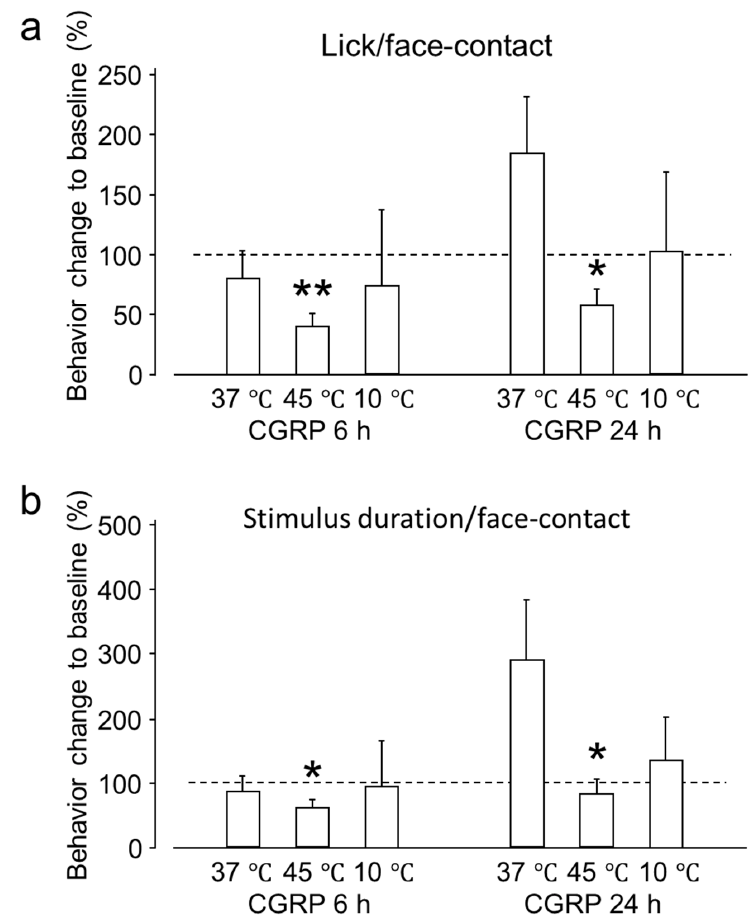
Figure 1. Behavioral outcome of intra-ganglionic (IG) calcitonin gene-related peptide (CGRP) administration. ( a ) The reward-licking events/face-contact events (L/F) ratio (mean ± standard